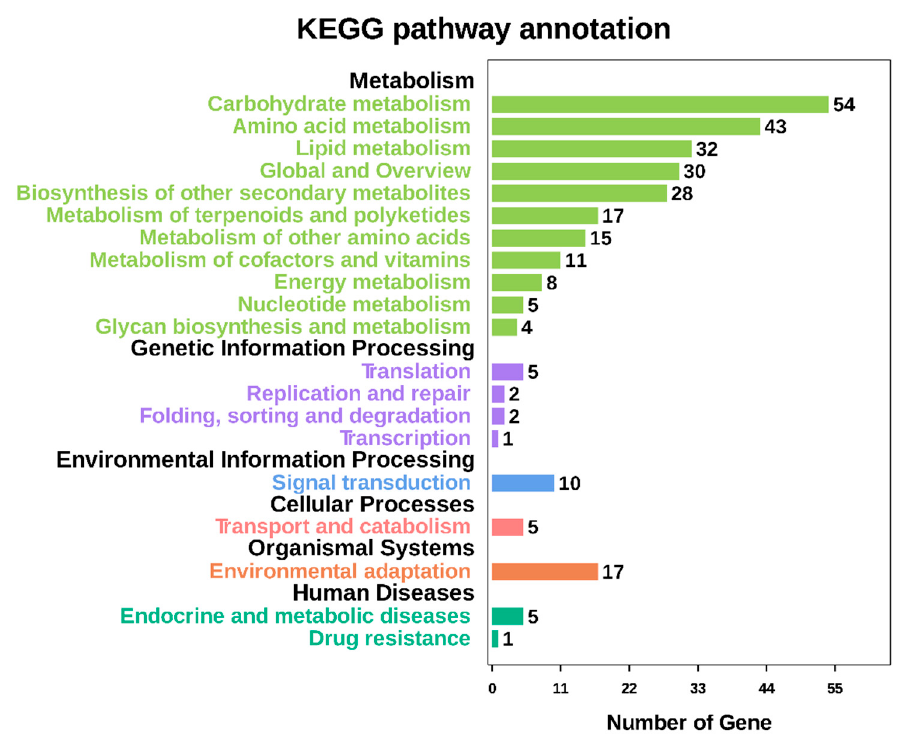
Figure 11. Classification of KEGG (2148 DEGs).